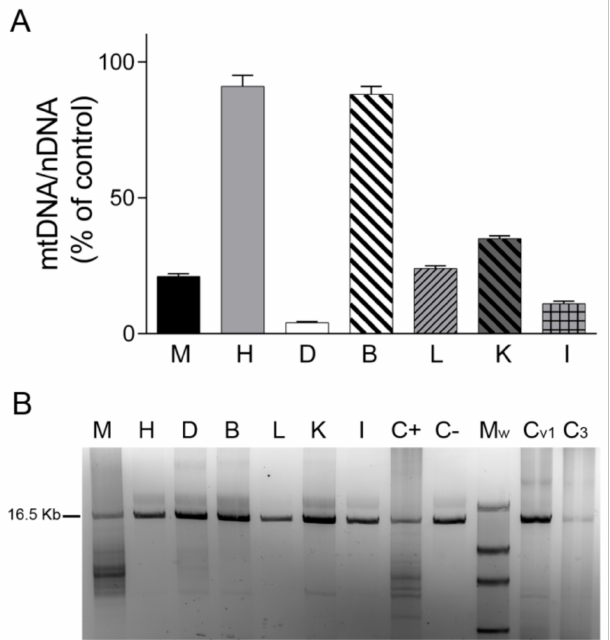
Figure 1. mtDNA content and mtDNA deletions. ( A ) mtDNA/nDNA copy-number ratio analyzed by real-time PCR in different tissues of the patient expressed as a percentage of the corresponding control tissue. Data are mean ± SD of three independent determinations. ( B ) Agarose gel showing mtDNA amplified by long-range PCR in different tissues of the patient and in control diaphragms. Normal sized amplicon of 16.5 kb is indicated. Lower molecular weight bands are suggestive of mtDNA deletions. A lower-size band of presumably non-specific amplification can be observed in B, K and controls. Abbreviations: M, skeletal muscle; H, heart; D, diaphragm; B, brain; L, liver; K, kidney; I, small intestine; C+, skeletal muscle positive control for mtDNA deletions; C − , skeletal muscle negative control for mtDNA deletions; Mw, Roche DNA Molecular Weight Marker II (Merck, Sigma-Aldrich, Darmstadt, Germany); Cv 1 , ventilated control diaphragm 1; C 3 , non-ventilated control diaphragm